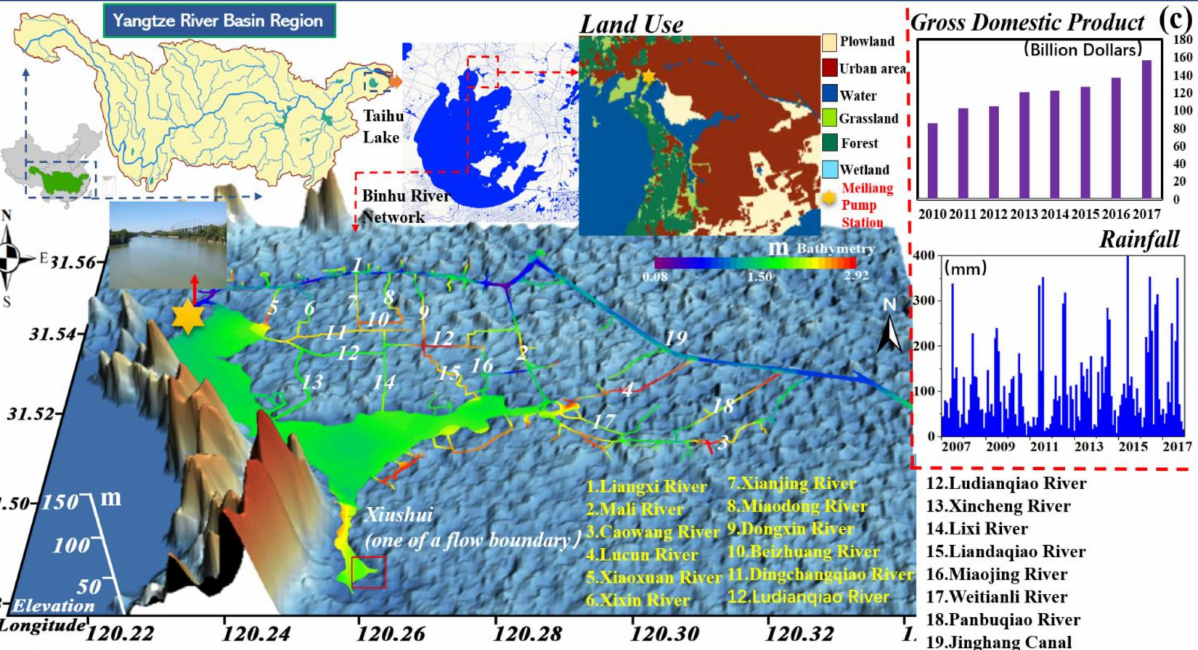
Figure 1. Study area map, ( a ) the geographical location and land use of the study area; ( b ) the topographic map of the study area and names of main rivers; ( c ) the annual Gross Domestic Product and the daily rainfall of the study